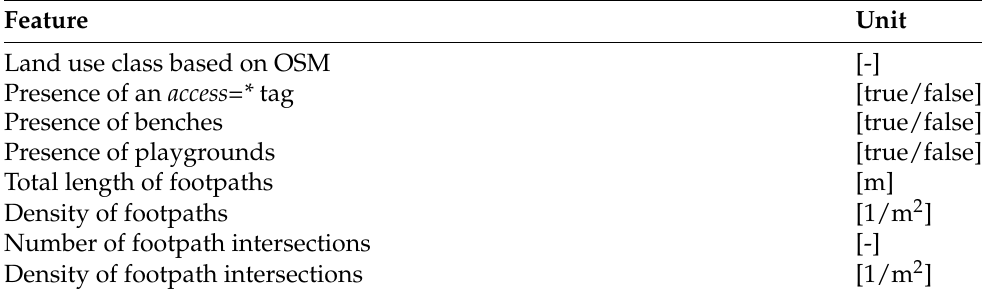
Table 3. Indicators which were considered to distinguish public from private green spaces. Land use class and access=* tag were derived in Section 4.3.1. The others were selected based on Ludwig et al.